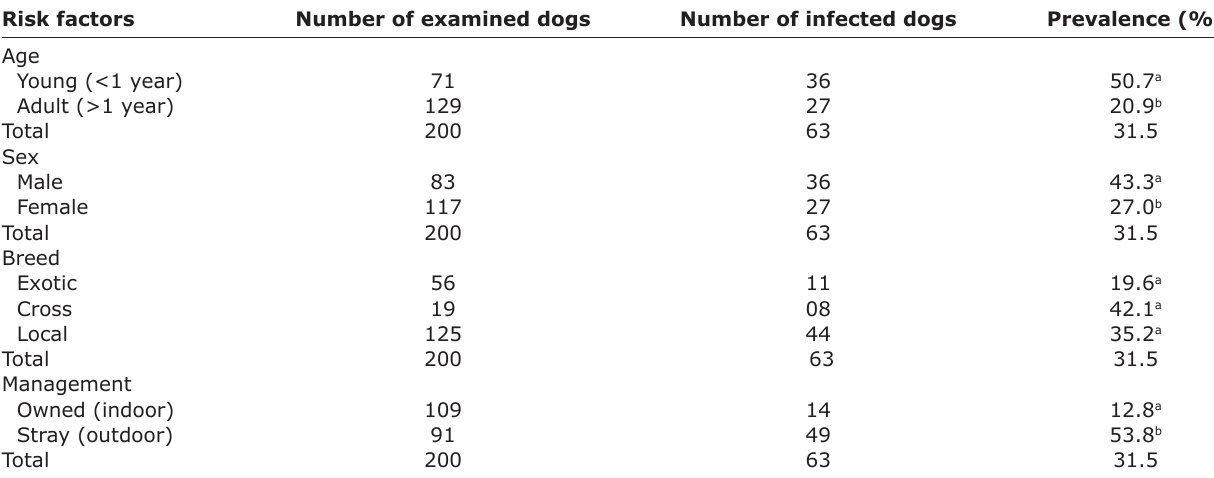
Table-1: Prevalence and associated risk factors of gastrointestinal parasites of dogs ( Canis familiaris ) in Maiduguri, Borno State, Northeastern Nigeria.